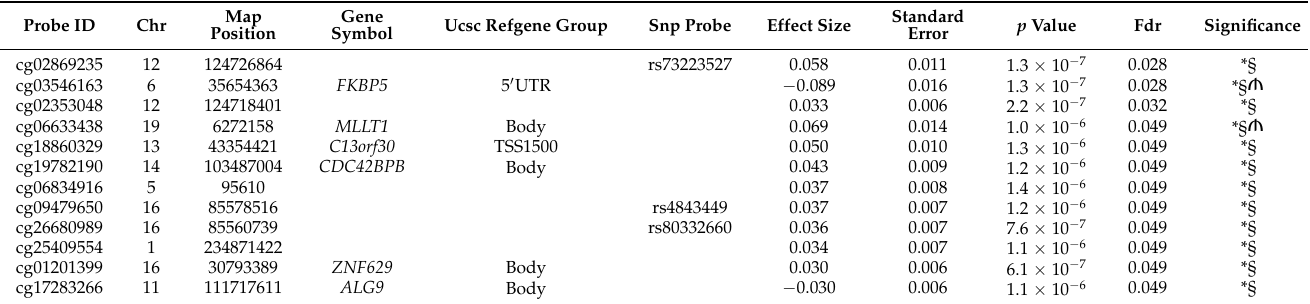
Table 1. Differential DNAm analyses ordered by effect size. Information about single-CpGs, including location-related values and model outputs (effect size, standard error, p values).